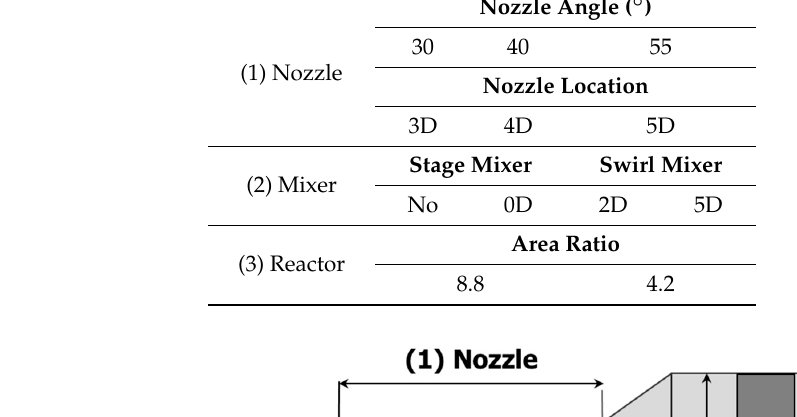
Figure 2. Schematic of SCR system development process.